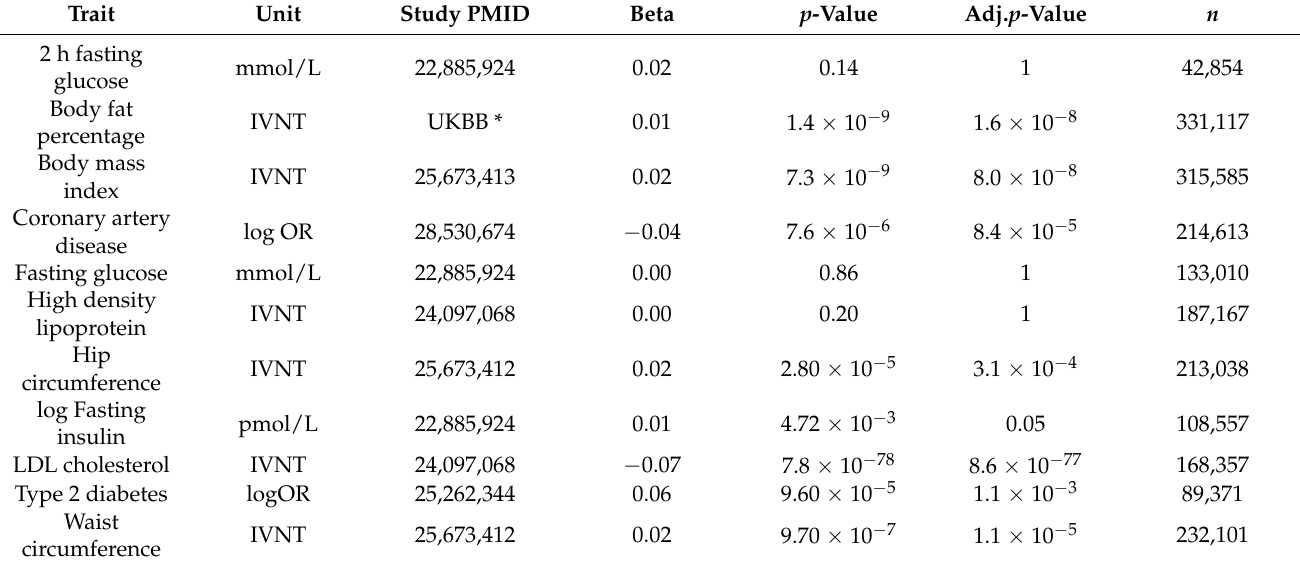
Table 2. Association of the T-allele of rs12916 (Chr. 5, position: 74656539) with diabetes and diabetes-related traits in large published